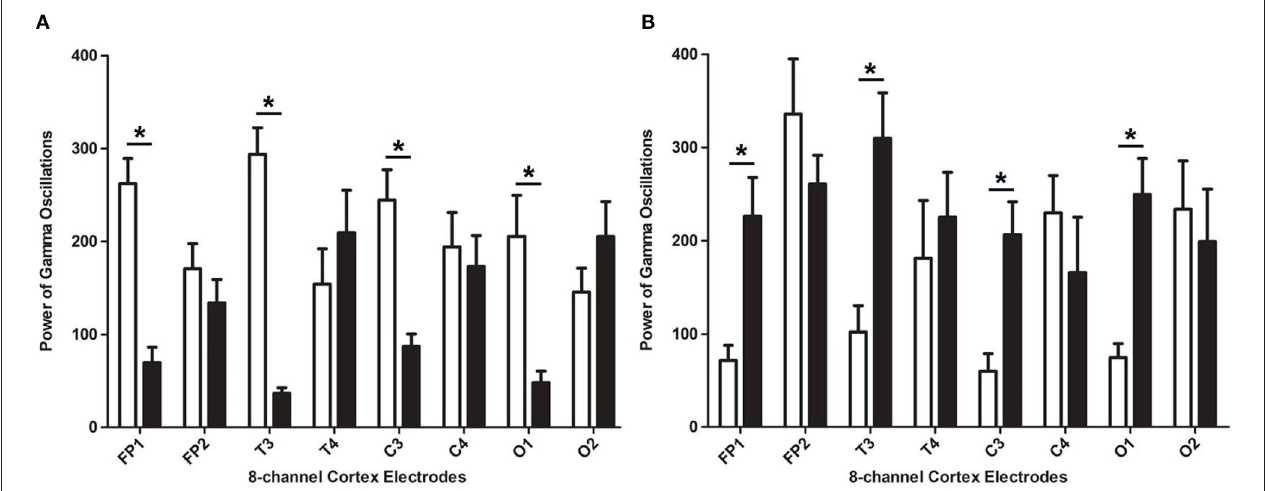
FIGURE 5 | The absolute energy of gamma oscillations of left-side TBI group in different electrodes. (A) Absolute energy of gamma oscillations of rat before and after TBI. The white bar represents control group (b), and the black bar represents TBI (L, 7d). (B) Absolute energy of gamma oscillations of TBI with and without 7-days treatment of 40hz Blue LED. The white bar represents TBI (L, 7d), and the black bar represents TBI (L) + 40hz light (7d). P -values correspond to one-way ANOVA. Data are expressed as mean ± SEM. * P < 0.05.